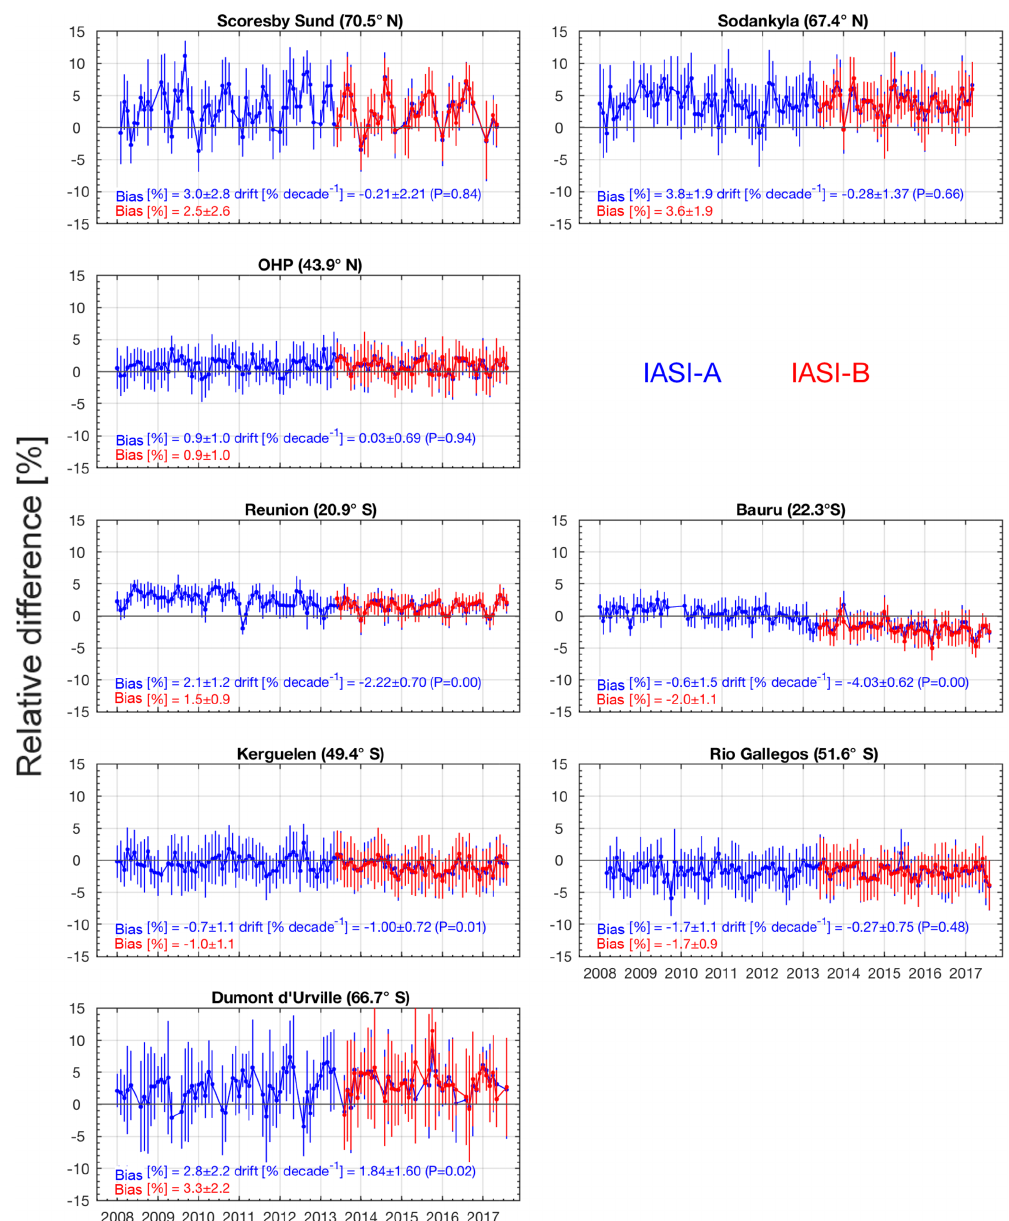
Figure 11. Time series of the monthly relative differences (in percent) between IASI-A (blue) and IASI-B (red) against collocated SAOZ TOC measurements for eight stations from north to south. For each daily SAOZ measurement, a relative difference is calculated as 100 × (IASI − SAOZ) / SAOZ [%]. All the relative differences are then monthly averaged. For the period from May 2013 onwards, only the common collocations between IASI-A and IASI-B are shown. The standard deviation of the average is also displayed (vertical bars). Comparison statistics including the mean bias and its 1 σ standard deviation (in percent) for the period from 2008 to 2017 (IASI-A) and 2013 to 2017 (IASI-B) are indicated on each panel. The decadal drift, its 2 σ standard deviation (in percent) and the P value for the IASI-A time series are also indicated on each